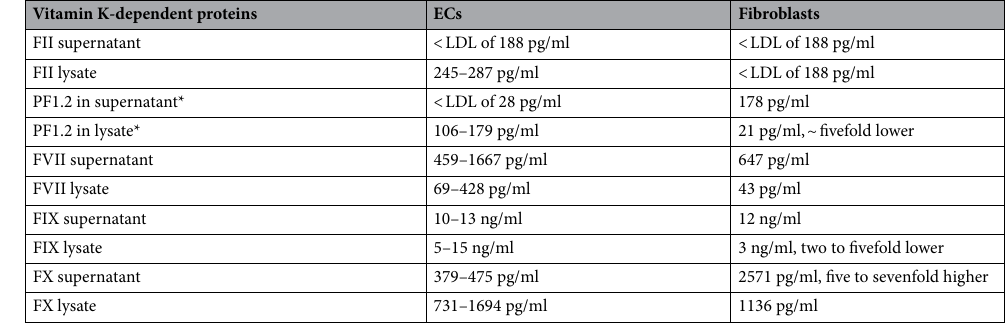
Table 2. Comparison of vitamin K-dependent coagulation protein levels in the supernatant and lysate/cell membrane fractions of ECs and fibroblasts. Protein levels of the vitamin K-dependent coagulation proteins in the supernatant and lysate/cell membrane fractions of ECs (HUVEC, GMVEC, LSEC) and fibroblasts. There are higher concentrations of these proteins in EC lysates than in fibroblast lysates. *Values from the current study. The other values are from Cohen et al. 6